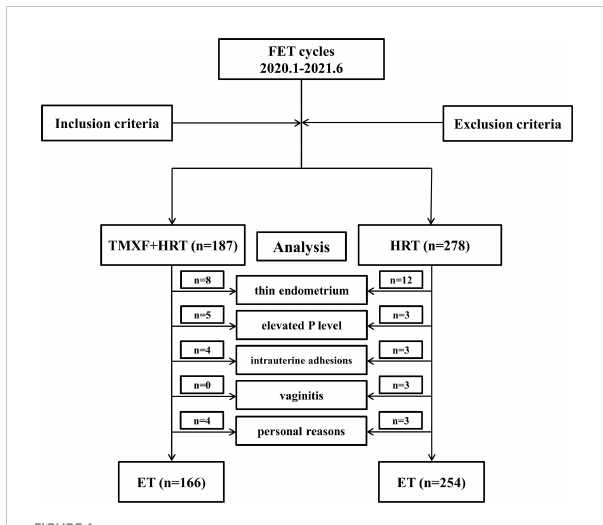
FIGURE 1 Flow chart of the patient inclusion and exclusion